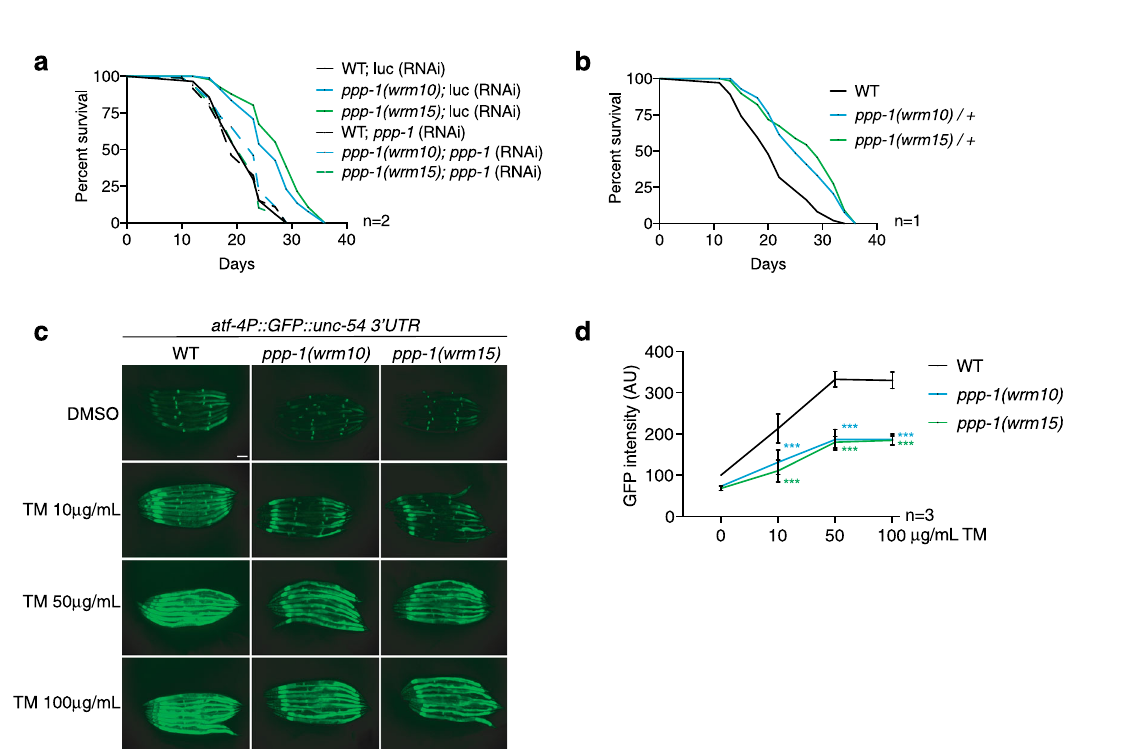
Fig. 4 Mutations in ppp-1 reduce the ISR upon stress. a Survival of WT animals and ppp-1 mutants upon RNAi treatment targeting ppp-1 or control luciferase (representative data from n = 2 independent experiments). b Survival of heterozygous ppp-1 mutants compared to WT control animals. c Fluorescence images of day 1 WT animals and ppp-1 mutants in the atf-4P ::GFP:: unc-54 3 ′ UTR reporter background. Worms were treated with DMSO only (control) or with the indicated tunicamycin (TM) concentrations for 6 h each (scale bar 75 µ m; representative data from n = 3 independent experiments with ≥ 7 animals each). d Quanti fi cation of GFP intensity in ( c ). Error bars represent means ± SD, two-way ANOVA Dunnett ’ s post hoc test with *** p < 0.001 vs. WT ( n = 3 independent experiments with ≥ 7 animals each). See Supplementary Dataset 1 for survival statistics. Source data are provided as a Source Data fi